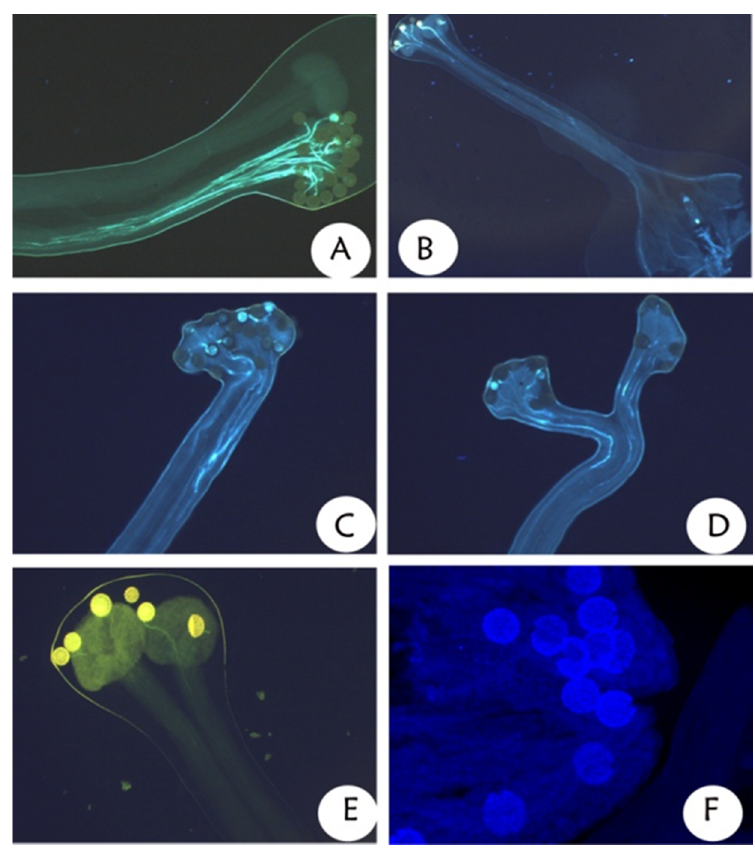
Figure 7. Fluorescent experiments of pollen germination of P. criopolitanum. ( A ) L-morph intermorph pollinations; ( B ) S-morph legitimate pollinations; ( C ) L-morph illegitimate pollination; ( D ) S-morph illegitimate pollination. ( E ) Selfing of L-morph; ( F ) Selfing of